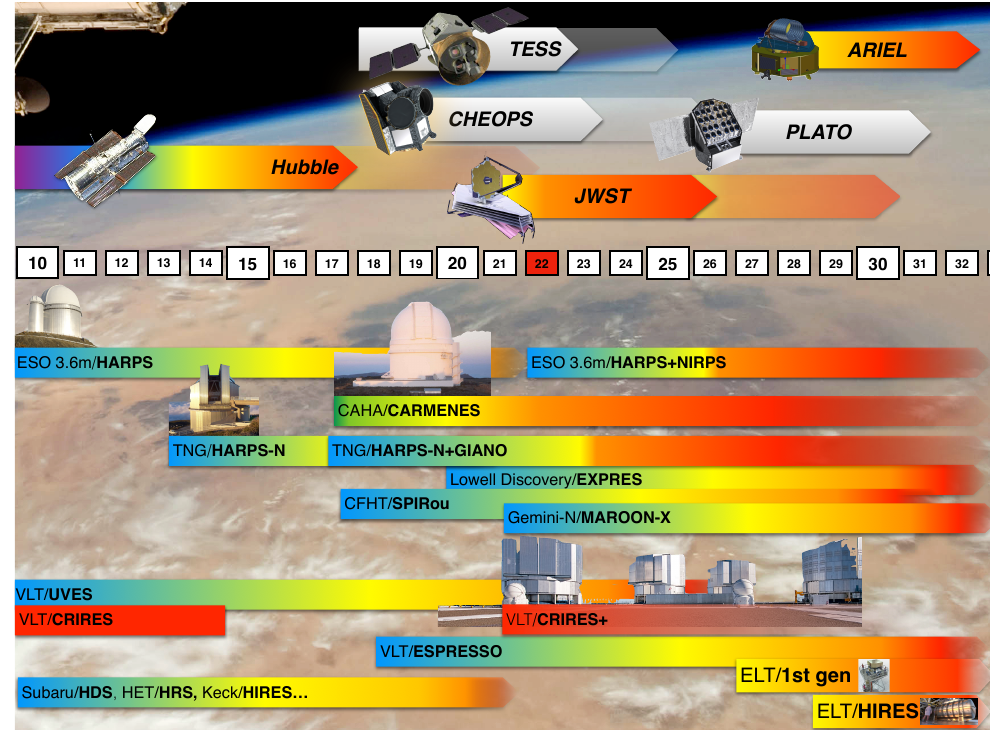
Figure 4. Space- and ground-based telescopes/instruments able to perform atmospheric characteri- zation since 2010. We also show the future telescopes/instruments that will come into use during this decade. We see that the number of telescopes/instruments is becoming very large, in particular since 2016, with many overlapping that can simultaneously observe targets with space- or ground-based instruments. Courtesy of David